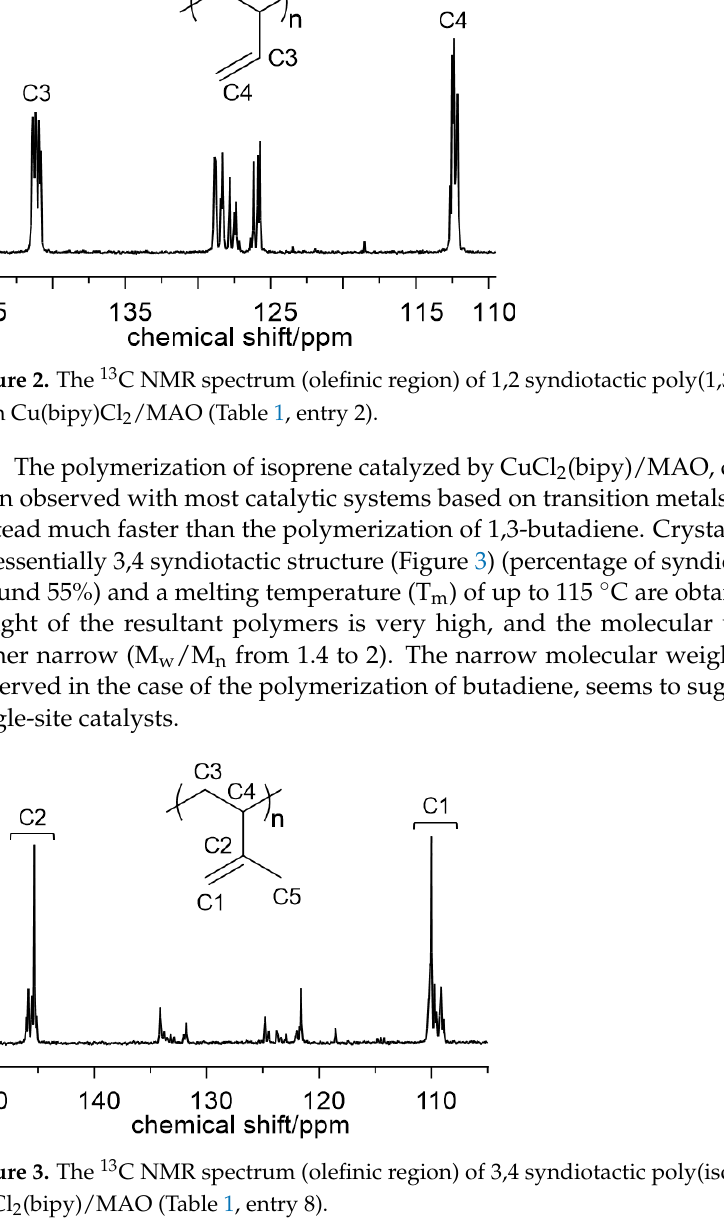
Figure 2. The 13 C NMR spectrum (olefinic region) of 1,2 syndiotactic poly(1,3-butadiene) obtained with Cu(bipy)Cl 2 /MAO (Table 1, entry 2).